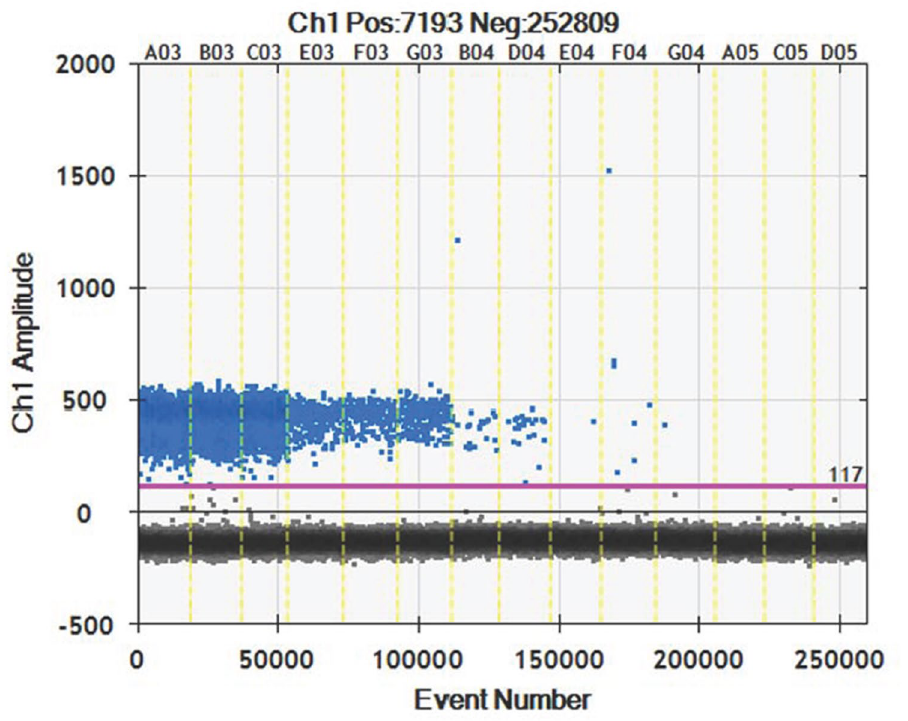
Figure 6. Distribution diagram of droplets of T. laevis and T. controversa isolates by droplet digital PCR. A03–C03, DNA template of T. laevis (30 ng/µl); E03–G03, DNA template of T. laevis (3 ng/µl); B04–E04, DNA template of T. laevis (0.3 ng/µl); F04–A05, DNA template of T. laevis (30 fg/µl), C05–D05, ddH 2 O control; blue dots are positive droplets, and black dots are negative